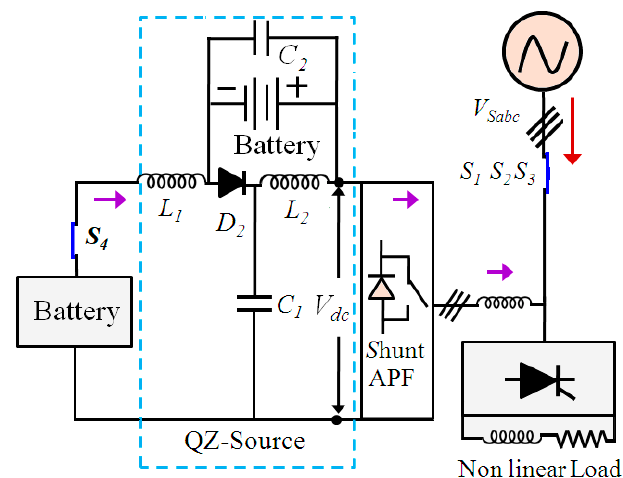
Figure 3. Current flow diagram for mode of battery backup.